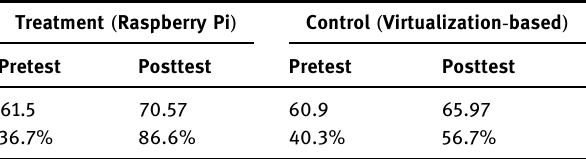
Table 4: Summary of student interest in network operating